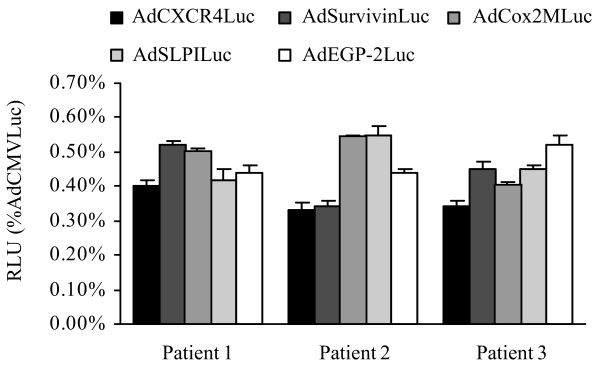
Analysis of candidate promoters for transcriptional targeting of adenovirus-mediated gene expression in normal breast tissue slices. Human normal breast tissue slices (from three patients undergoing mammoplasty) were infected with AdCXCR4Luc, AdSurvivinLuc, AdSLPILuc, AdEGP-2Luc, AdCox2MLuc or AdCMVLuc. Gene expression was measured 24 h after infection and is presented for the candidate promoters as percentage of cytomegalovirus promoter activity in relative light units (RLU). All data points are of triplicate slices; bars represent means ± standard deviation.